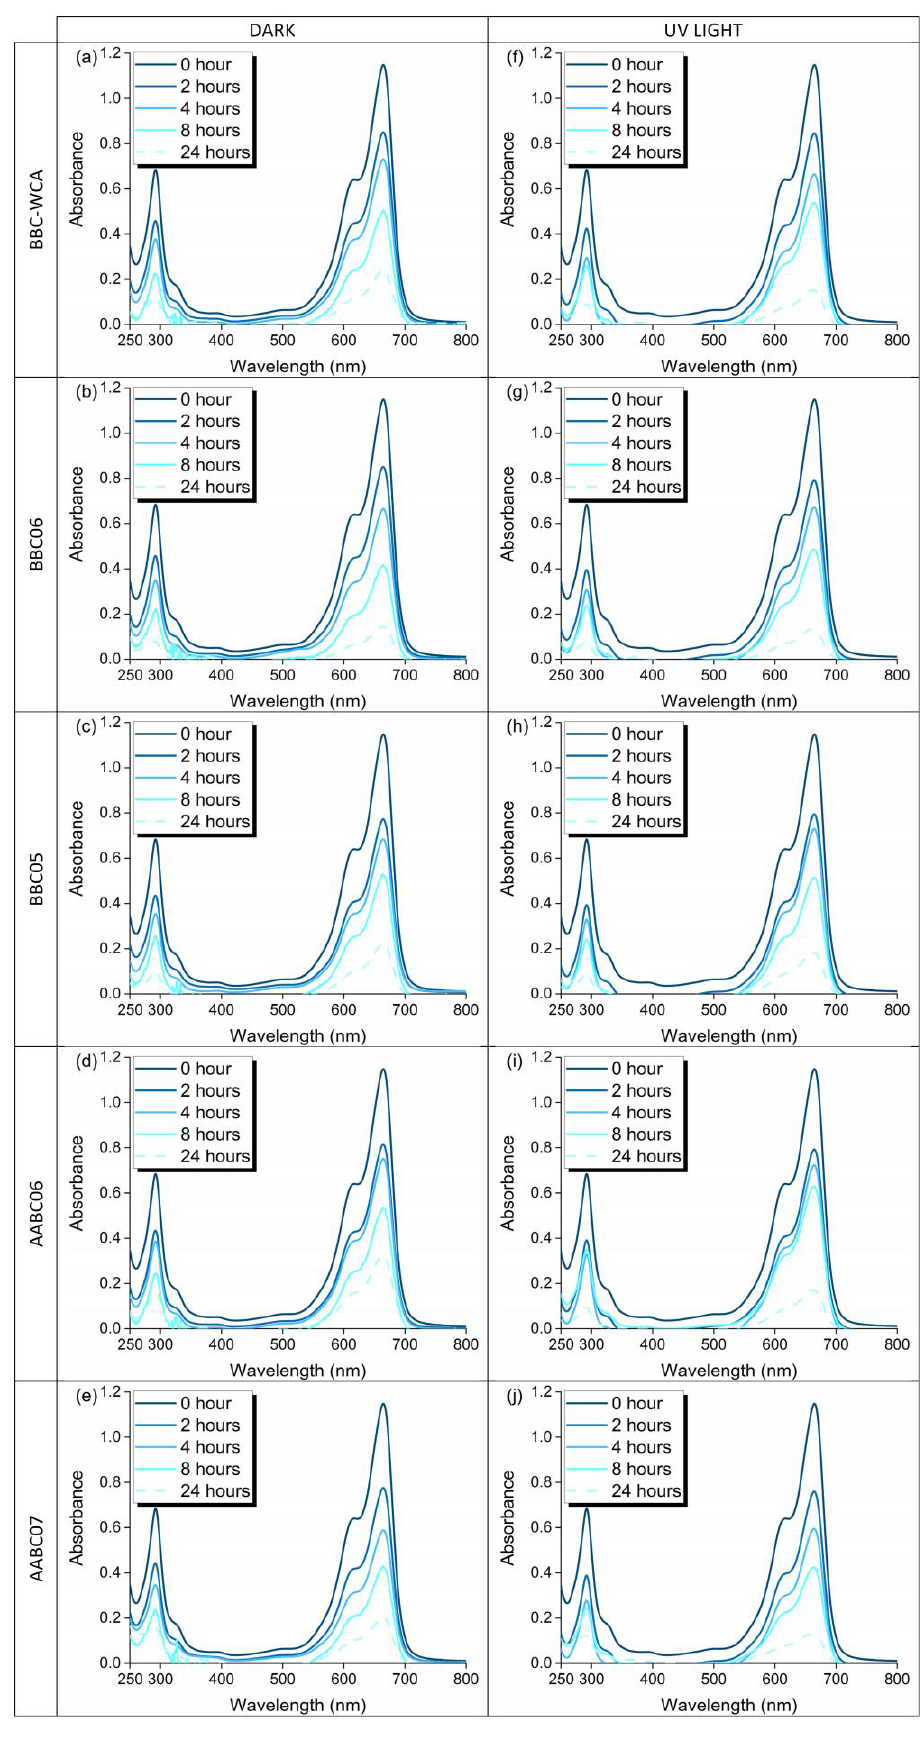
Figure 18. Absorbance curves for each mixture ( a–e ) in the dark and ( f–j ) under UV light.